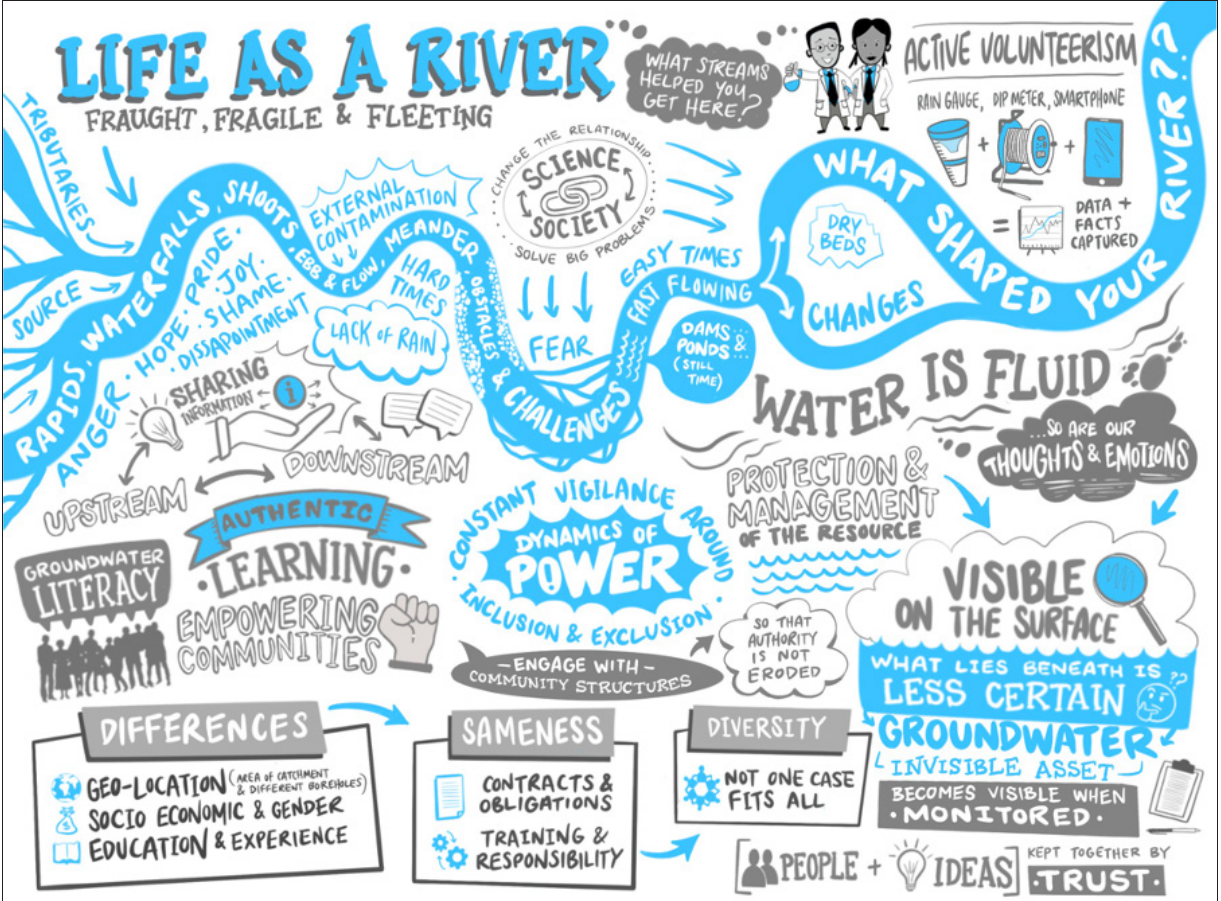
Figure 2 Storyboard entitled Life as a